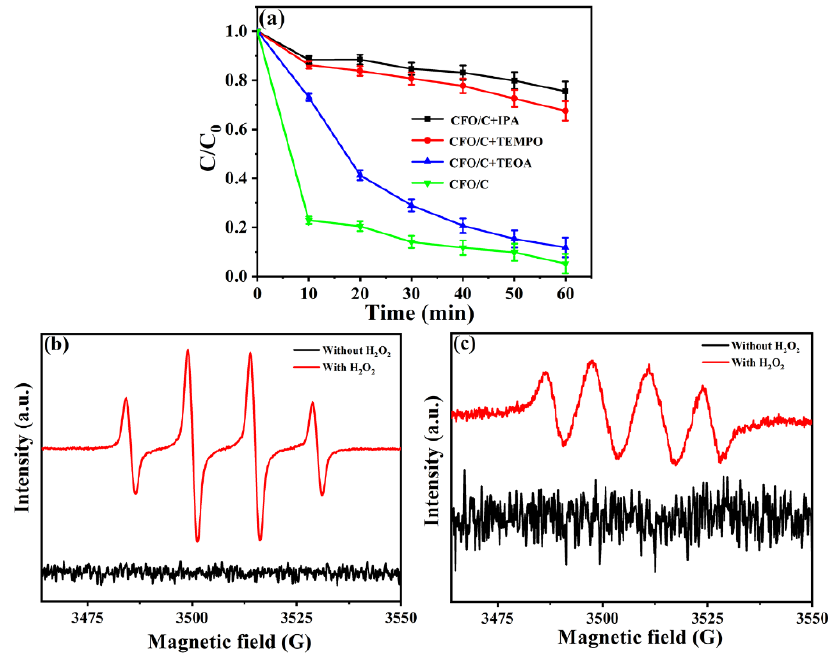
Figure 11. ( a ) The effects of various scavengers on photocatalytic activity of CFO/C-PNSs in photo-Fenton degradation condition; ( b , c ) the electron spin response (ESR) spectra.